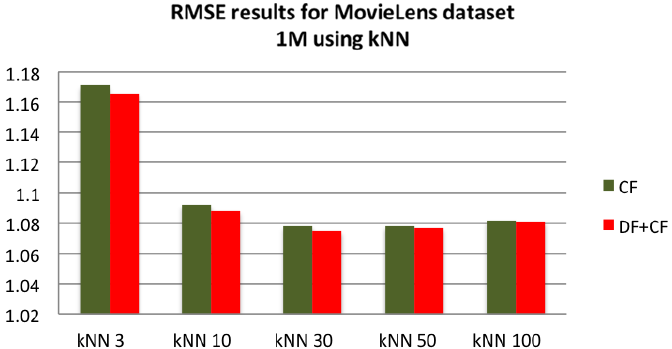
Fig. 5. RMSE results for the MovieLens dataset using kNN.